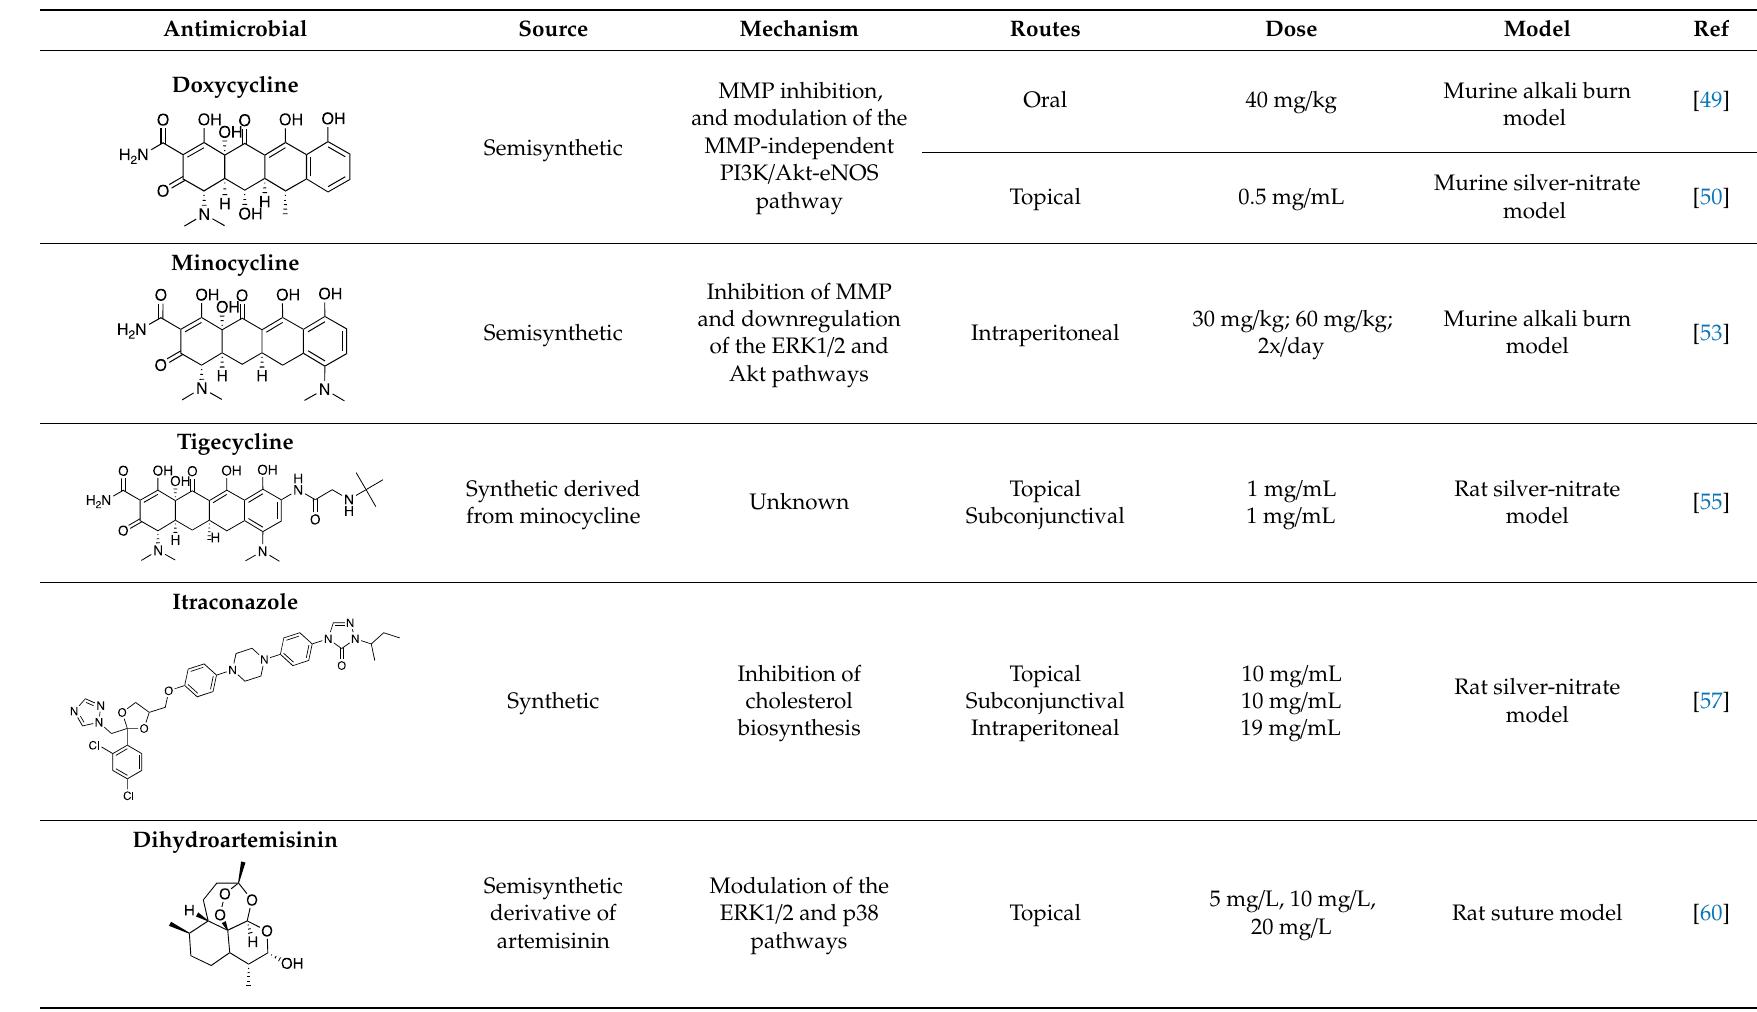
Table 2. Repurposed antimicrobials tested in CoNV models.